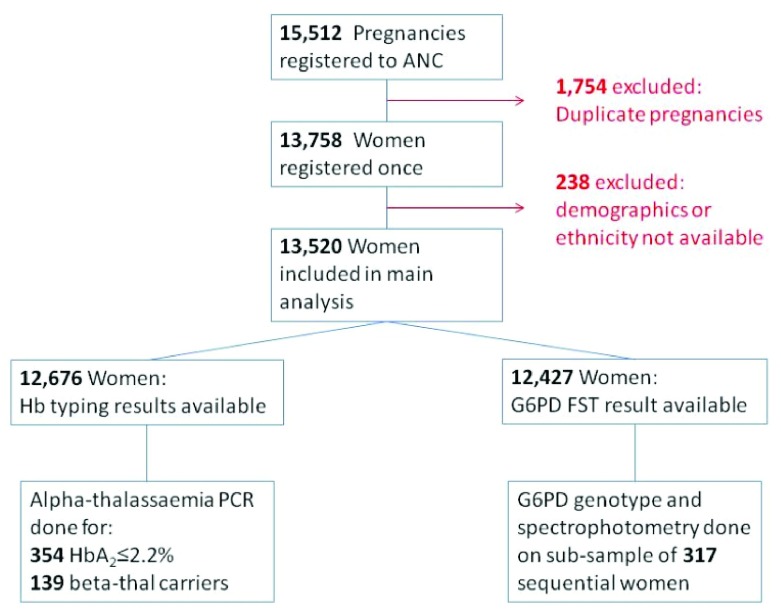
Study flowchart.